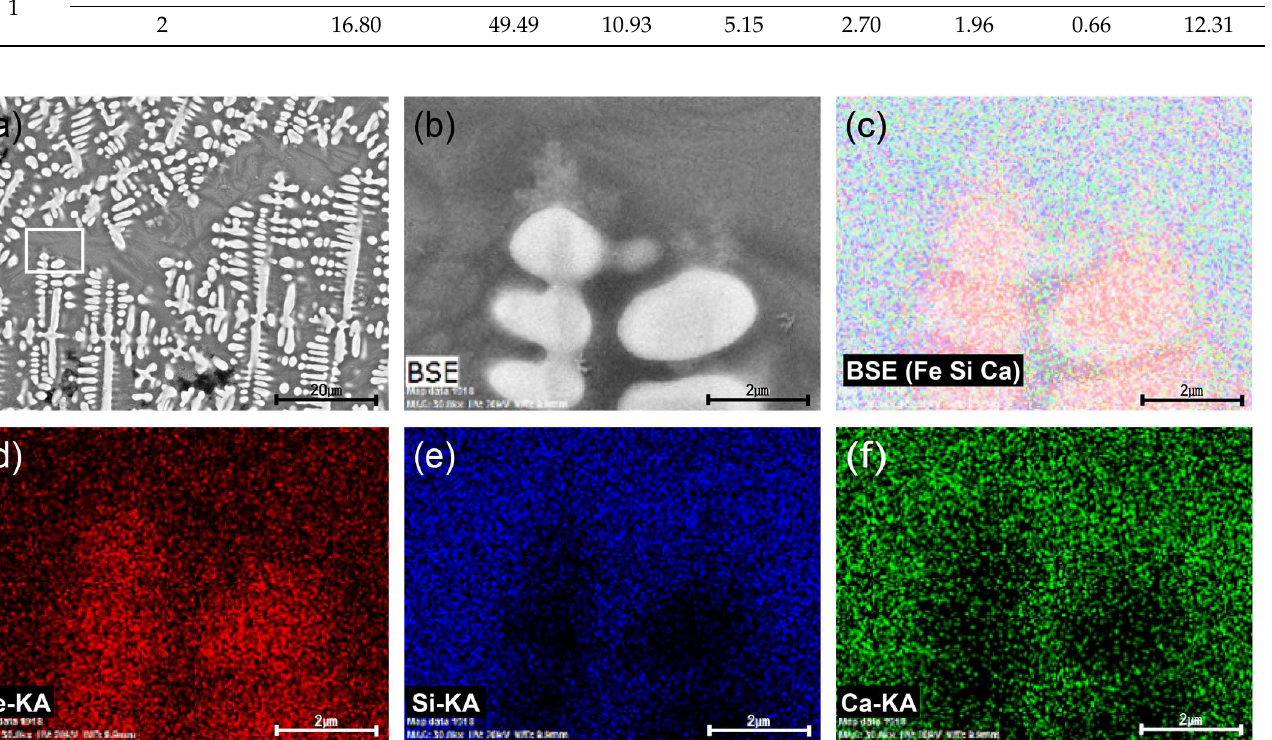
Figure 5. EDS mapping of spheroidal hammer scale (No. 1): ( a ) SEM image and position marking, ( b ) EDS mapping image, ( c ) distribution status of Fe, Ca, and Si elements, ( d ) Fe, ( e ) Si, ( f ) Ca.